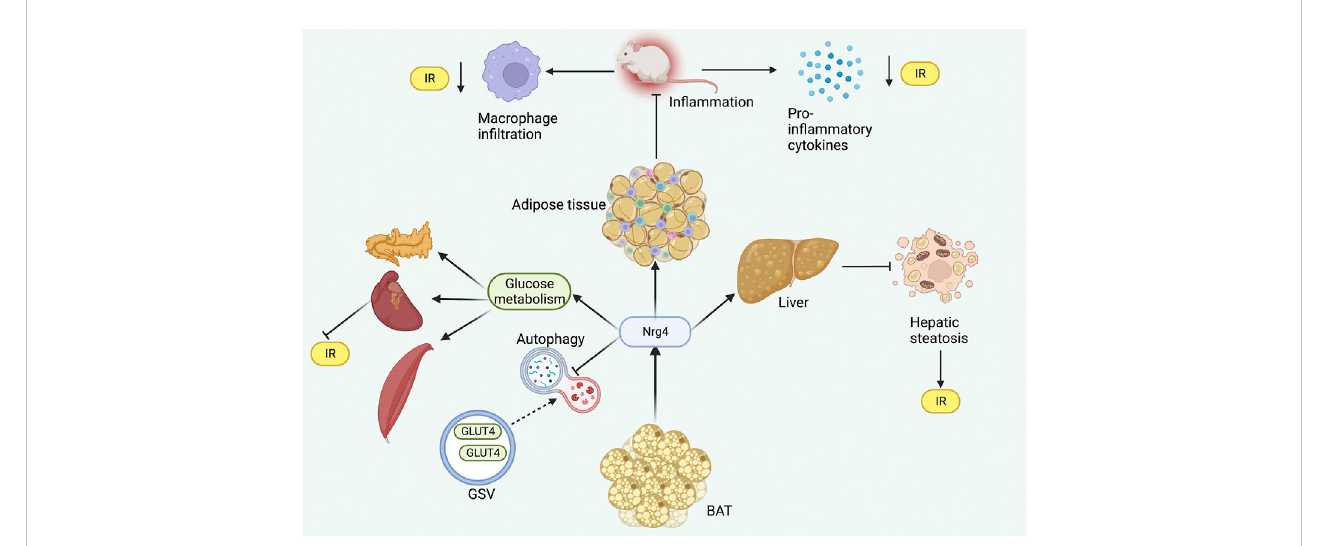
FIGURE 2 Role of Nrg4 in IR. Nrg4 ameliorates in fl ammation in adipose tissue by reducing macrophage in fi ltration and pro-in fl ammatory cytokine levels. Nrg4 improves systemic energy metabolism by increasing glucose metabolism in peripheral organs, while reducing autophagy in GSV. Nrg4 also improves IR by improving hepatic steatosis. Abbreviations: Nrg4, neuregulin four; BAT, brown adipose tissue; IR, insulin resistance; GLUT4, glucose transporter four; GSV, GLUT4 storage